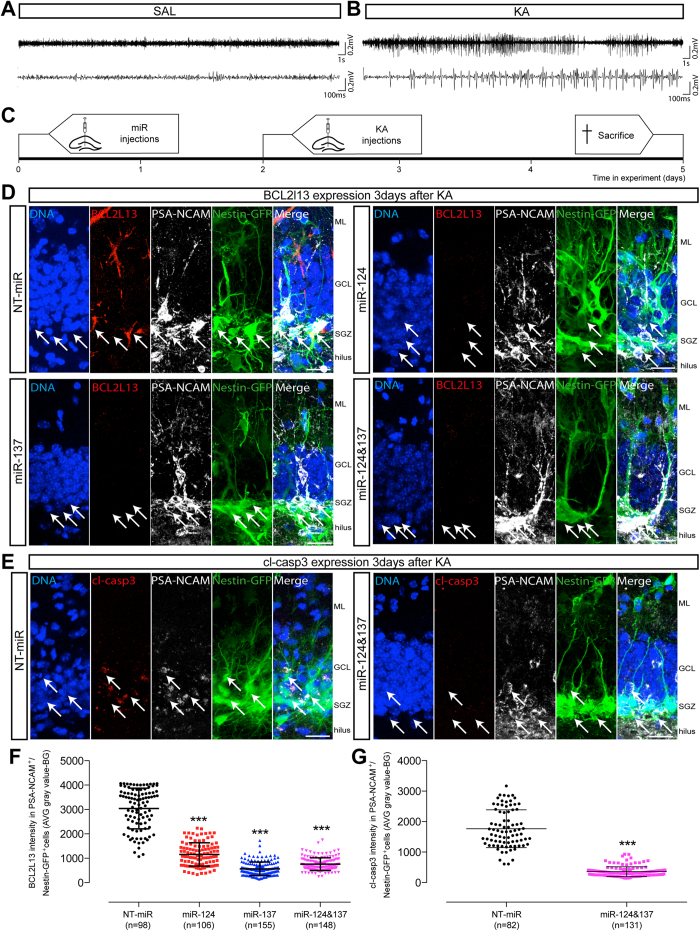
Regulation of BCL2L13 expression and casp3 activity by miR-124 and mir-137 in hippocampal NSPC in vivo after mild SE induced by intrahippocampal KA injection.(A) Representative low (top) and high (bottom) magnifications of cortical EEG recordings from freely moving animals 2 h after intrahippocampal SAL injections. (B) Representative low (top) and high (bottom) magnifications of cortical EEG recordings from freely moving animals 2 h after intrahippocampal KA injections, depicting peak epileptoform activity. (C) Schematic timeline of the experiment. Nestin-GFP mice received miR (1 μl, 50 μM total) intrahippocampal injections on day 0, intrahippocampal KA injections on day 2 and were sacrificed 3 days later, on day 5. (D) Representative confocal images of animals injected with miR + KA. Top left: Nestin-GFP+/PSA-NCAM+/BCL2L13 + cells (arrows) in the SGZ of mice that received NT-miR and KA. Top right: Nestin-GFP+/PSA-NCAM+/BCL2L13 + cells (arrows) in the SGZ of mice that received miR-124 + KA. Bottom left: Nestin-GFP+/PSA-NCAM+/BCL2L13 + cells (arrows) in the SGZ of mice that received miR-137 + KA. Bottom right: Nestin-GFP+/PSA-NCAM+/BCL2L13 + cells (arrows) in the SGZ of mice that received miR-124&137 + KA. (E) Representative confocal images of animals injected with miR and KA. Left: Nestin-GFP+/PSA-NCAM+/cl-casp3 + cells (arrows) in the SGZ of mice that received NT-miR and KA. Right: Nestin-GFP+/PSA-NCAM+/cl-casp3 + cells (arrows) in the SGZ of mice that received miR-124&137 + KA. Scale bars: 20 μm (D and E). ML: molecular layer, GCL granular cell layer, SGZ: subgranular zone. (F) Dot plot showing BCL2L13 expression quantified as intensities calculated from background subtracted average gray values in individual Nestin-GFP+/PSA-NCAM + cells (miR-124, ***p < 0.001; miR-137, ***p < 0.001; miR-124&137, ***p < 0.001, relative to NT-miR). (G) Dot plot showing cl-casp3 expression quantified as intensities calculated from background subtracted average gray values in individual Nestin-GFP+/PSA-NCAM + cells (miR-124&137, ***p < 0.001, relative to NT-miR). Values represent mean background (BG) subtracted average (AVG) gray value ± SD of at least 3 animals (F and G).